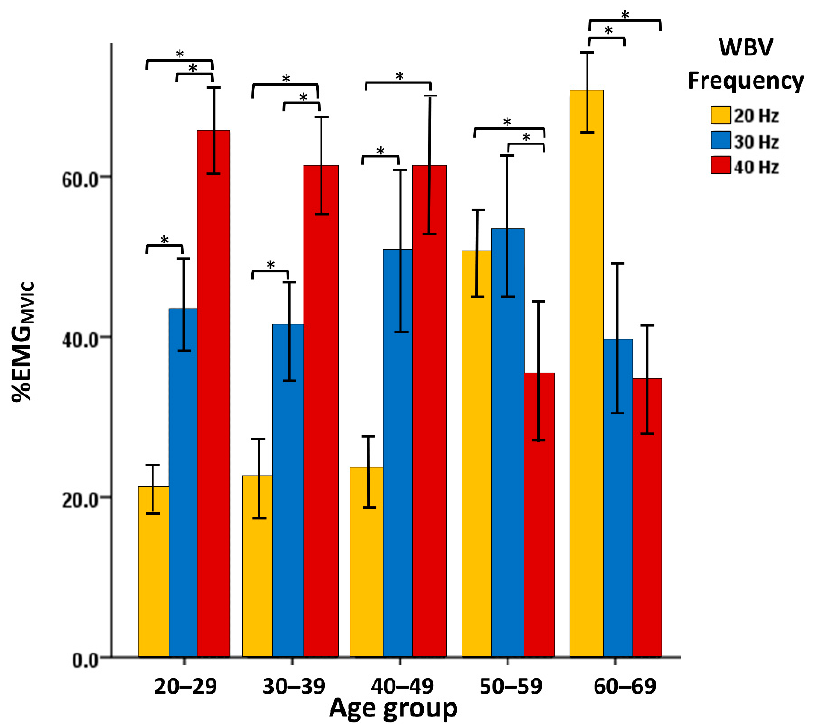
Figure 1. The neuromuscular activation of rectus femoris muscle during 20, 30, and 40 Hz whole- body vibration normalized by EMG MVIC . * p < 0.05; the values are presented as mean ± 1.96 SE (standard error).